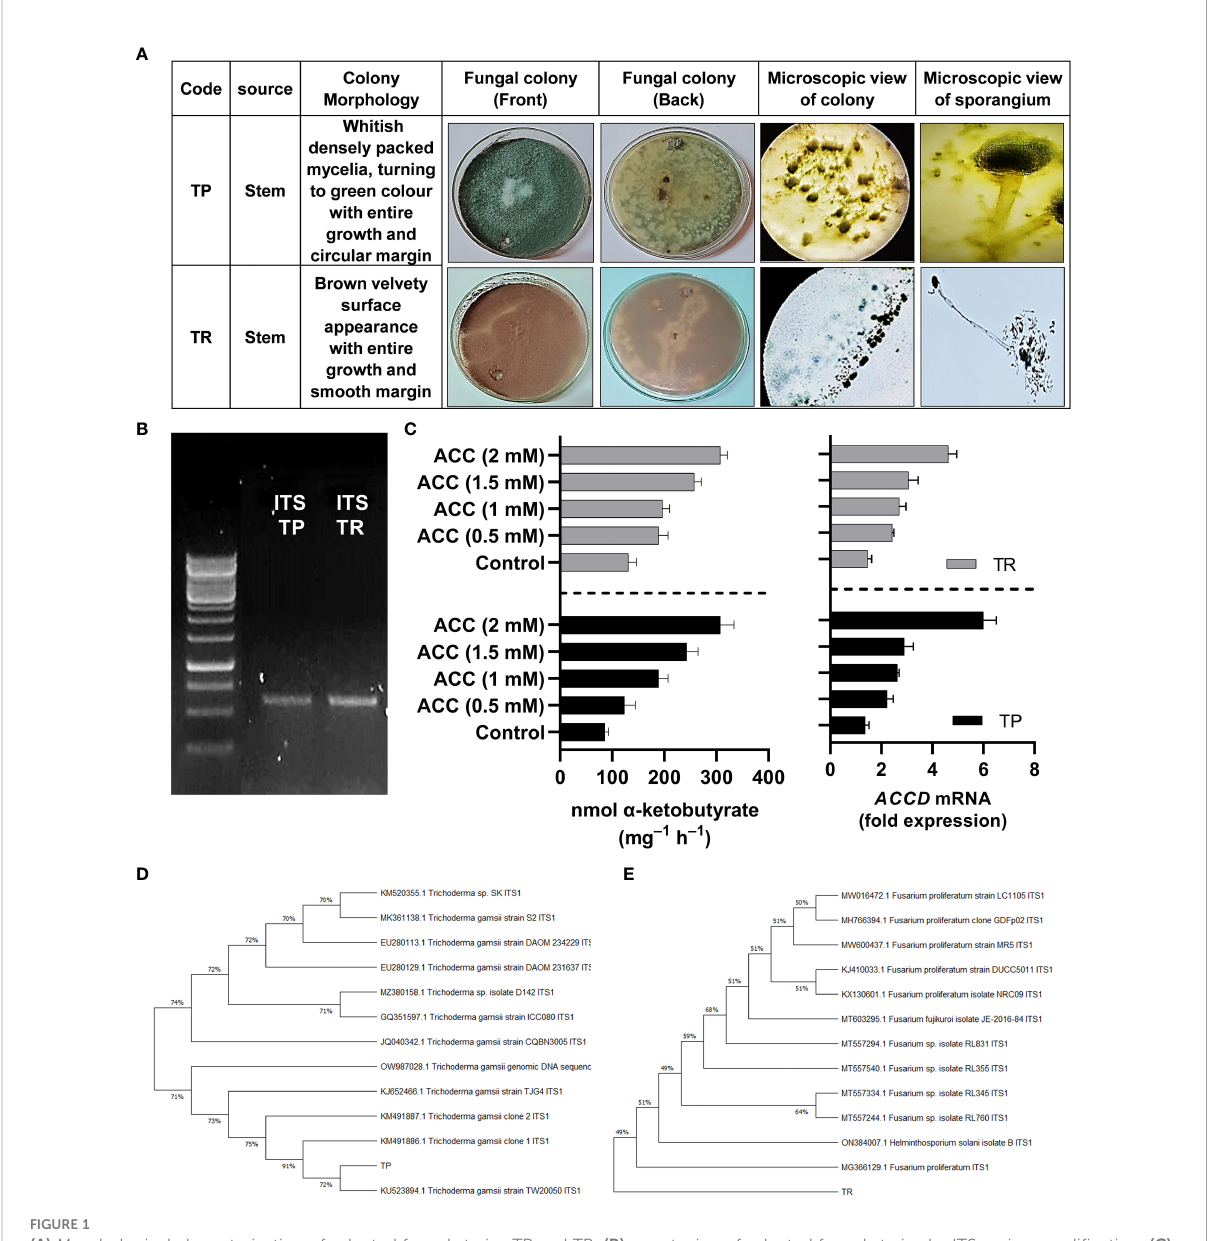
FIGURE 1 (A) Morphological characterization of selected fungal strains TP and TR, (B) genotyping of selected fungal strains by ITS region ampli fi cation, (C) ACC deaminase activity and ACC deaminase gene expression of TP and TR. Quantitative data represent means ± SD of three independent experiments and at least six technical replicates, (D) Phylogenetic identi fi cation of TP, and (E) TR endophytic